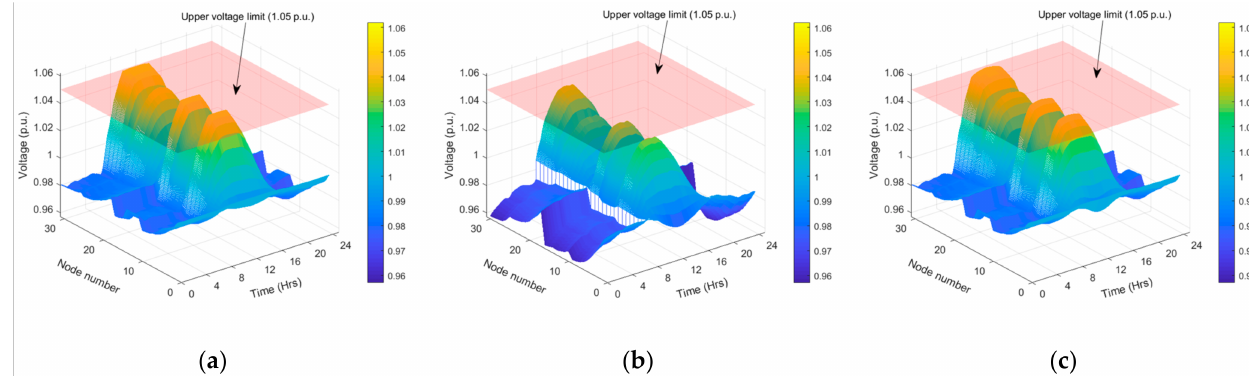
Figure 8. Daily variation of nodal voltages with the ( a ) Volt–Watt, ( b ) Fixed power factor, and ( c ) Volt–Var controls.